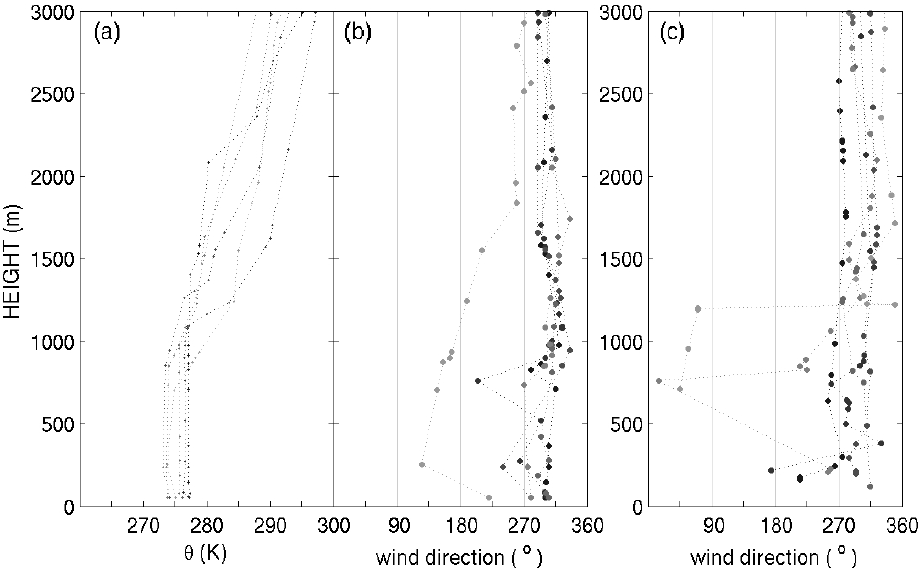
Figure 3. Vertical profiles of ( a ) potential temperature and ( b ) wind direction at Osan 06 UTC and ( c ) wind direction at Bukgangneung 00 UTC. Each profile was obtained from the day of flight in Seoul and Gangneung.